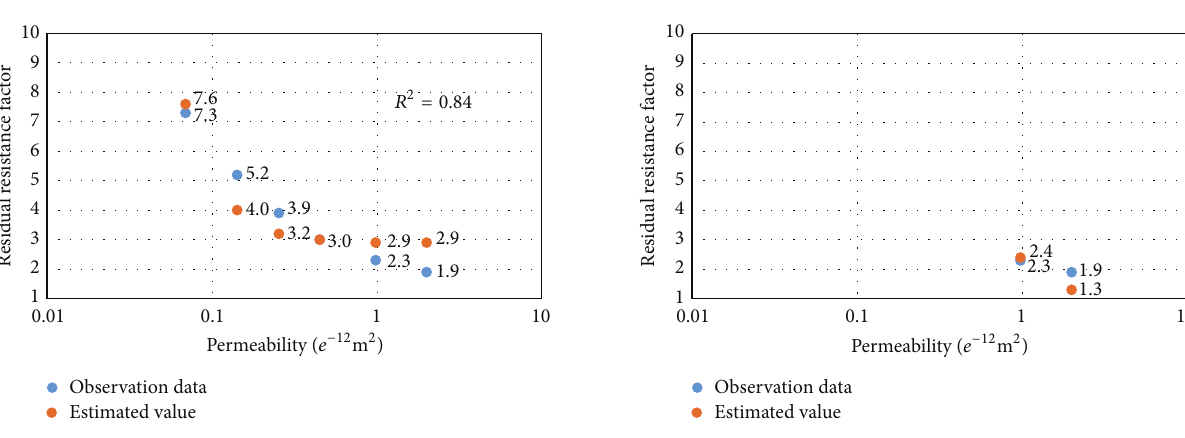
Figure 4: Matching results between observation and estimation using the correlation function of RRF = 𝑎 2 /𝑘 2 + 1.